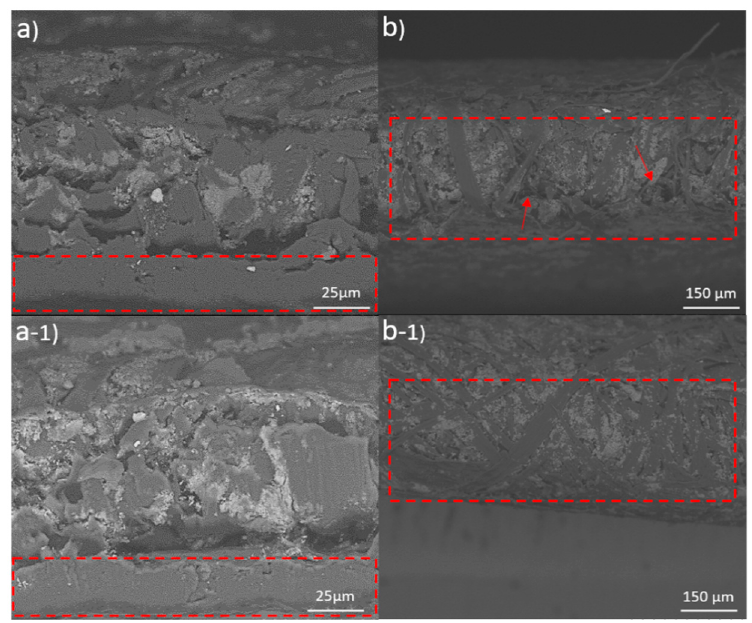
Figure 4. SEM images of coated papers with CNF from ( a ) cross-section and ( b ) the folded edge in tension. The corresponding LCNF images are indicated on the bottom panel as ( a-1 & b-1 ). Arrows in ( b ) show defects in the CNF film during the folding event.